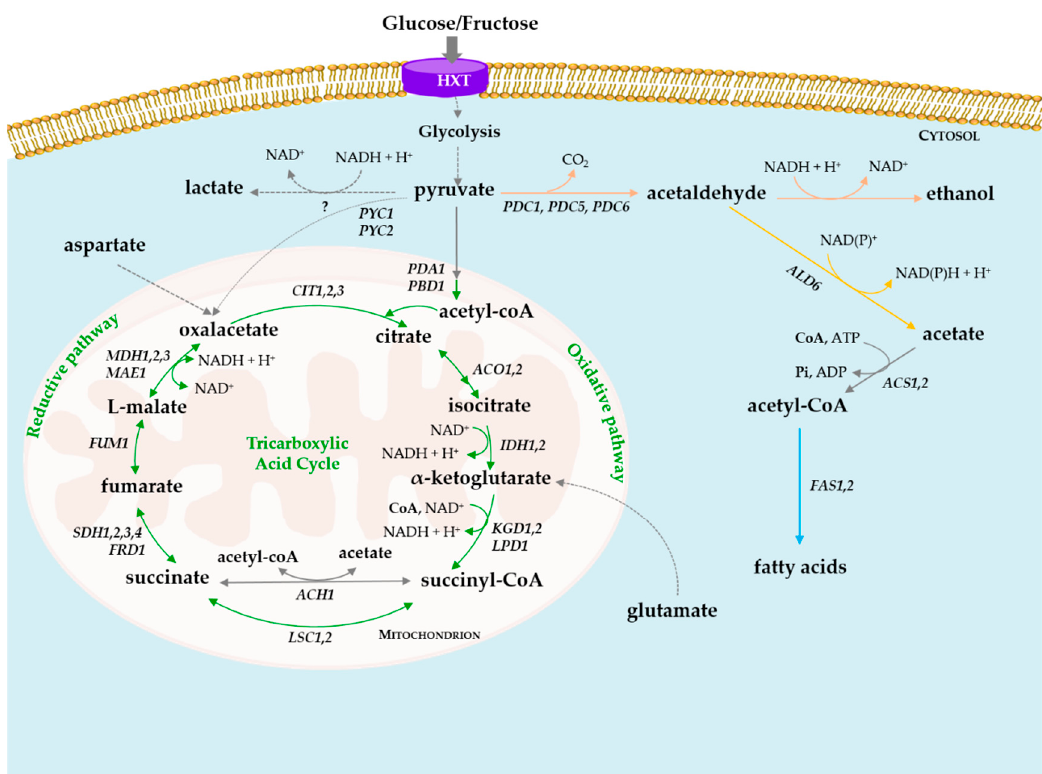
Figure 1. Schematic representation of the pathway of acids biosynthesis during fermentation. The reactions indicated are catalyzed by the enzymes, encoding by the following genes: PDC1,5,6 —